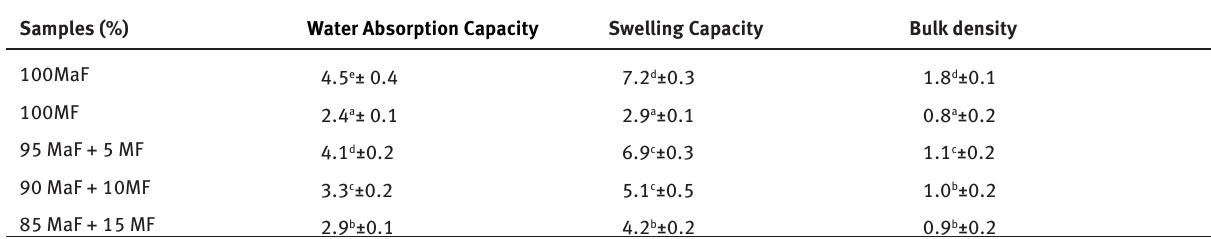
Table 2: Functional properties of maize ( Zea mays ) flour composited with mushroom ( Pleurotus ostreatus ) flour at different ratio (g/ml)